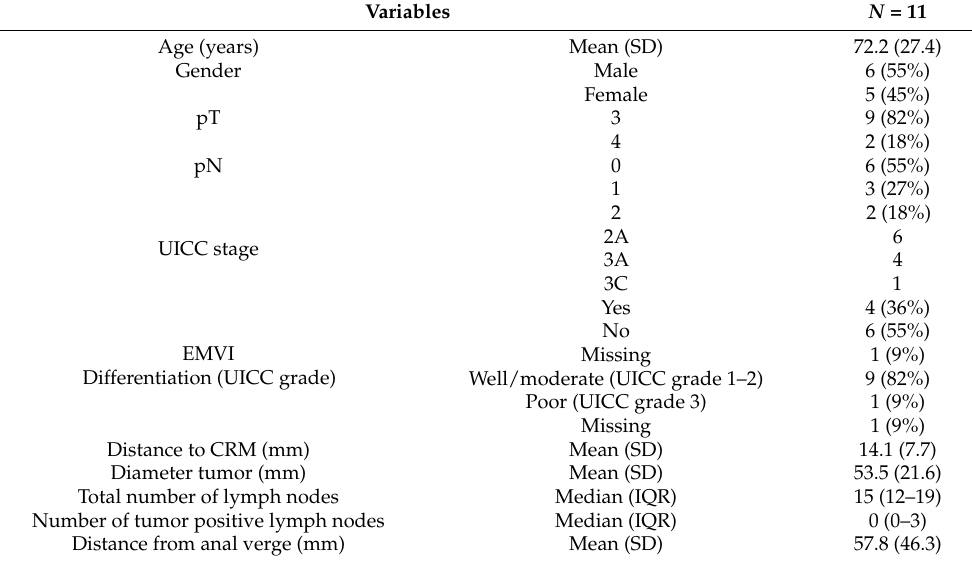
Table 2. Patient